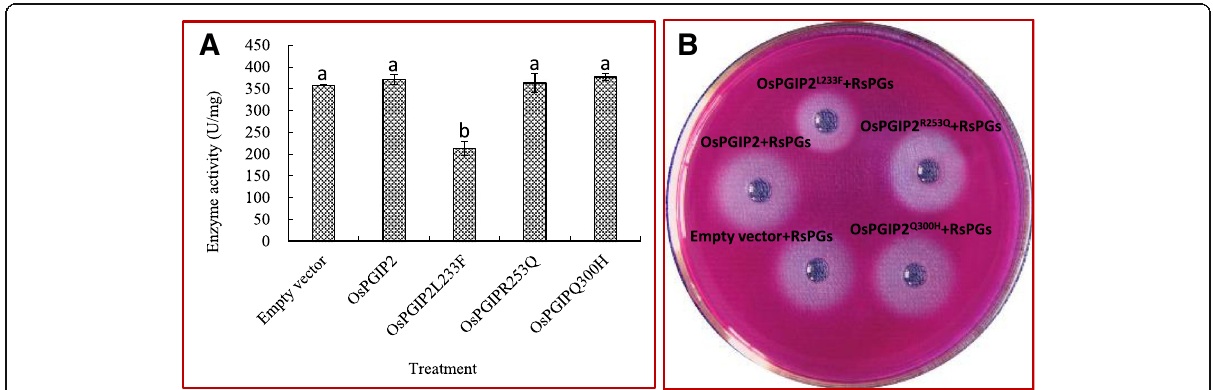
Fig. 5 Reduced sugar and diffusion assays for inhibition of RsPG activity. OsPGIP2 and mutant forms (OsPGIP2 L233F , OsPGIP2 R253Q , and OsPGIP2 Q300H ) were overproduced in E. coli BL21 and assayed for inhibition of RsPGs. a , The reduced sugar assay; b , The agar diffusion assay. Different lowercase letters on the bar show significant statistical difference between treatment and control at 5% significance level. Each bar represents the average and standard deviation of at least three